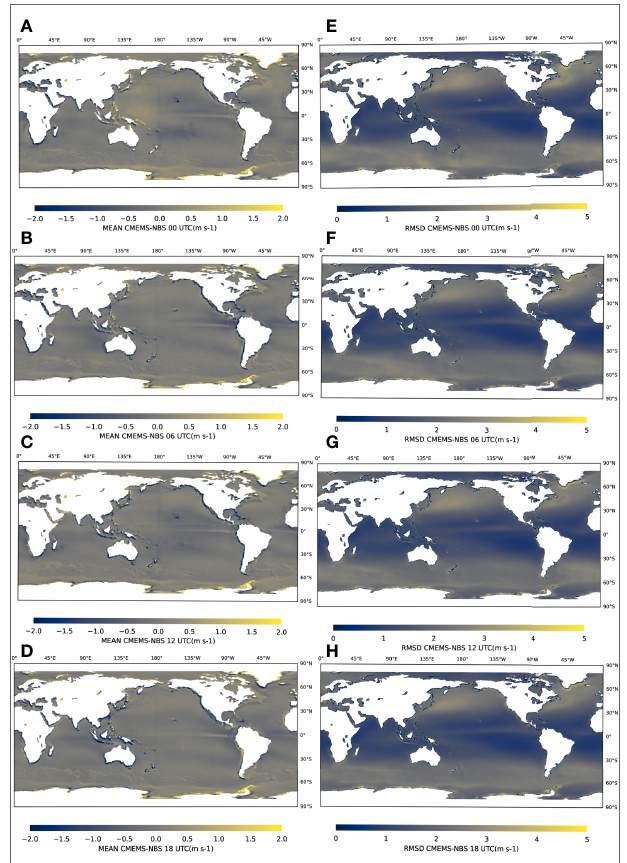
FIGURE 5 | Map of Copernicus Marine Environment Monitoring Service (CMEMS)—NBS v2.0 winds. (A–D) The mean of this difference field. (E–H) The root mean square difference (RMSD) for a time period of 28 years (1992– 2019) for four different synoptic times (0000, 0600, 1200, and 1800